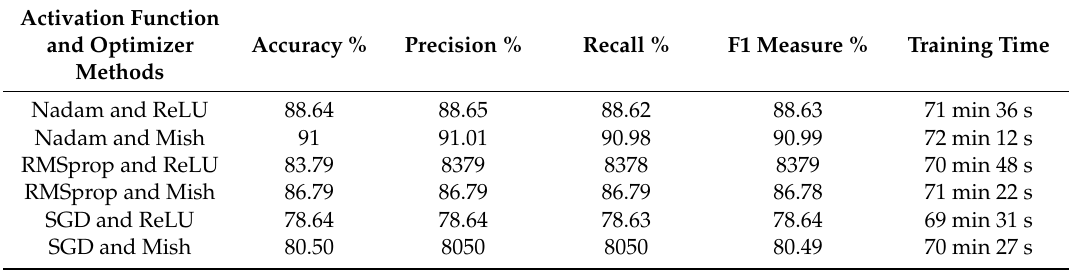
Table 4. The performance of Inception-V3 with ReLU and Mish combined with other optimizers. Activation Function and Optimizer